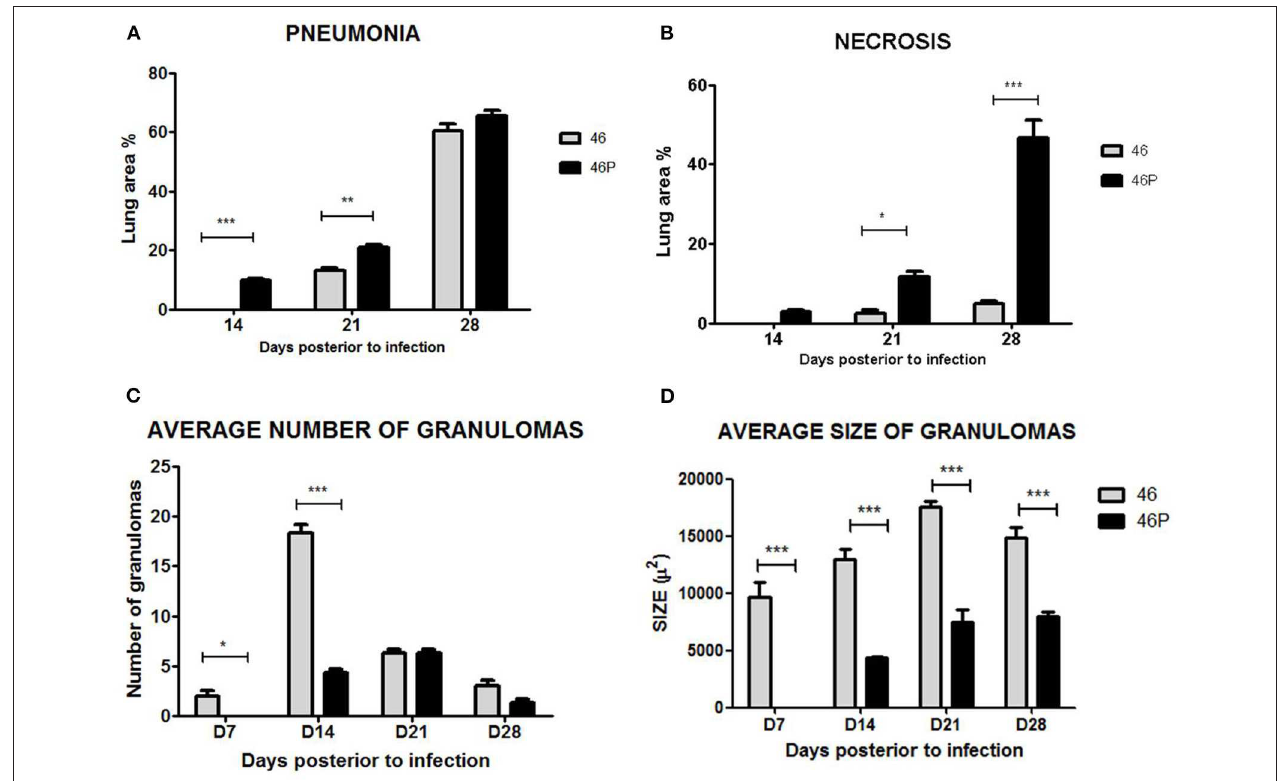
FIGURE 3 | (A) Lung area affected by pneumonia in animals infected by strain 46 and 46P. (B) Lung area affected by necrosis in animals infected by strain 46 and 46P. (C) Average number of granulomas in animals infected by strain 46 and 46P. (D) Average size of granulomas in animals infected by strains 46 and 46P. * p < 0.05, ** p < 0.01, *** p <